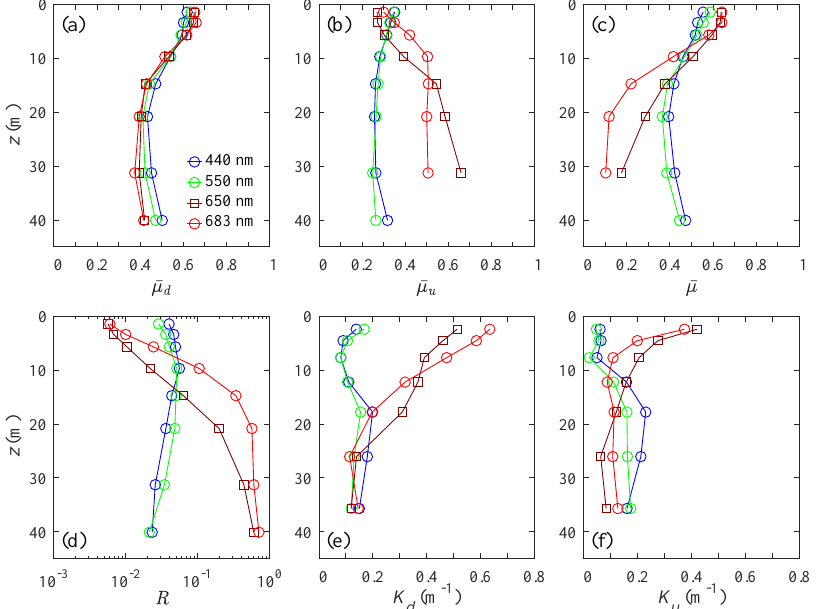
Figure 7. Vertical profiles of average cosines, irradiance reflectance, and diffuse attenuation coefficients for the station in the Farallon Basin shown in Figure 2b. Data for µ and K u ( f ) are shown for selected light wavelengths as indicated in panel ( a